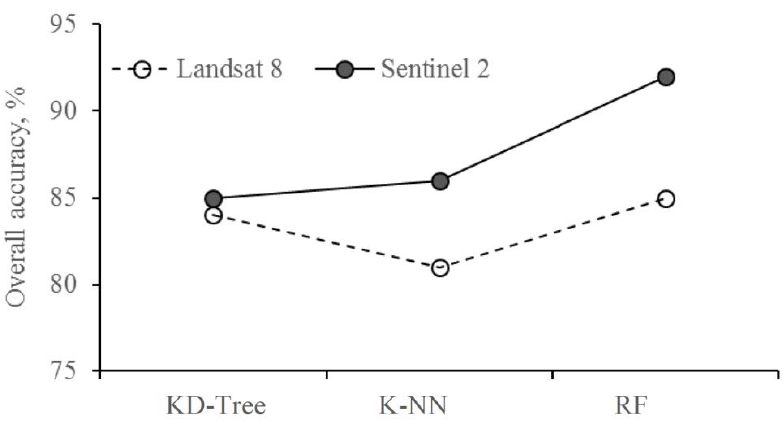
Figure 9. Overall accuracy comparison of two satellites using different classifiers.